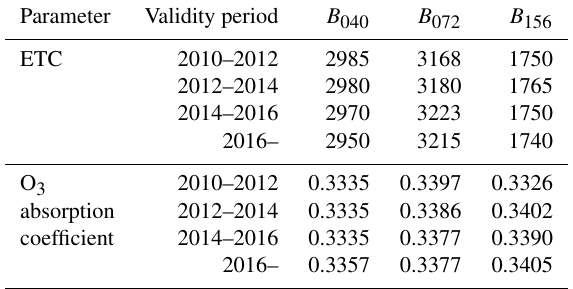
Table 1. ETC and ozone absorption coefficient of the Arosa triad Brewer instruments from the last three calibration campaigns. Parameter